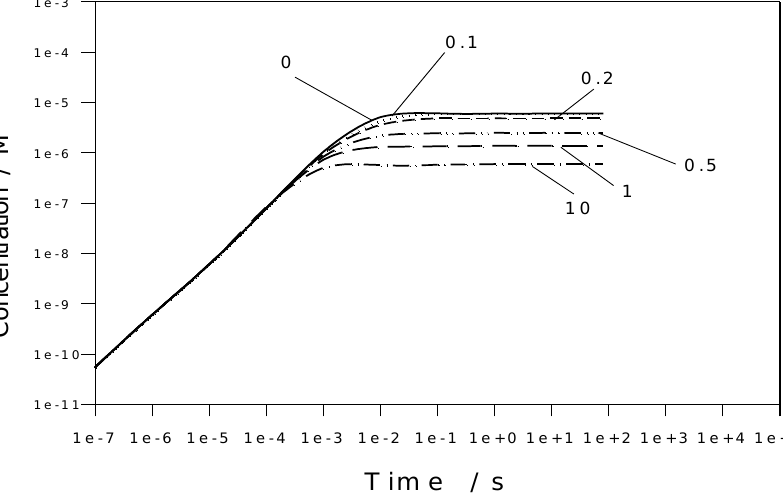
Figure 33. Predicted concentration of hydrogen peroxide in the single modeled module as a function of time for different initial concentrations of hydrogen in cc (STP)/kg H 2 O.